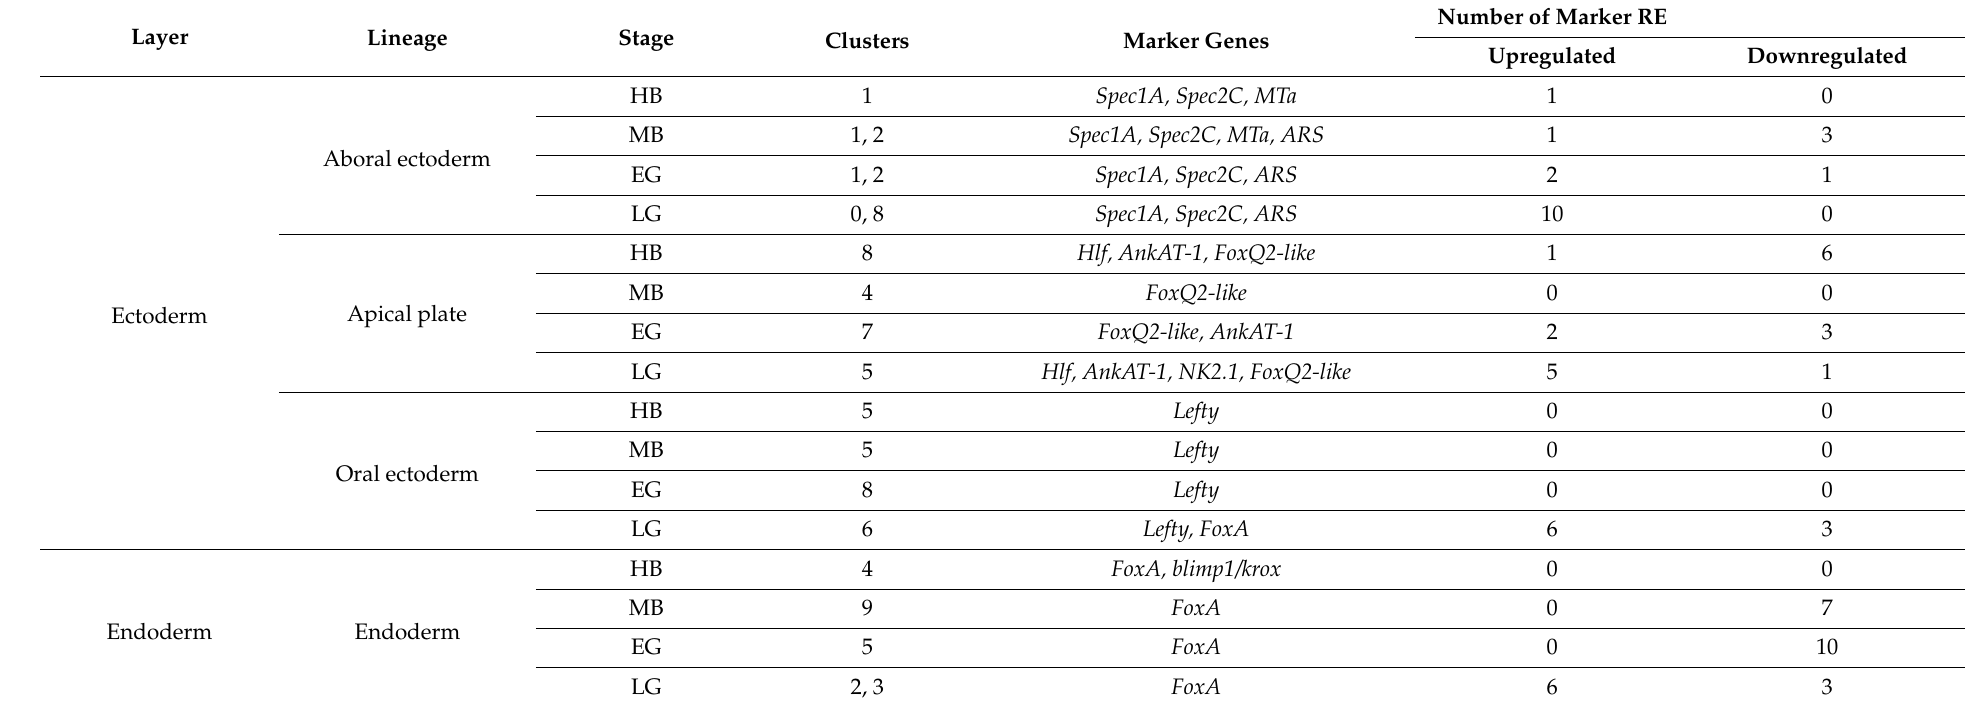
Table 1. Cell lineages in stages from hatch blastula to late gastrula and their marker genes and